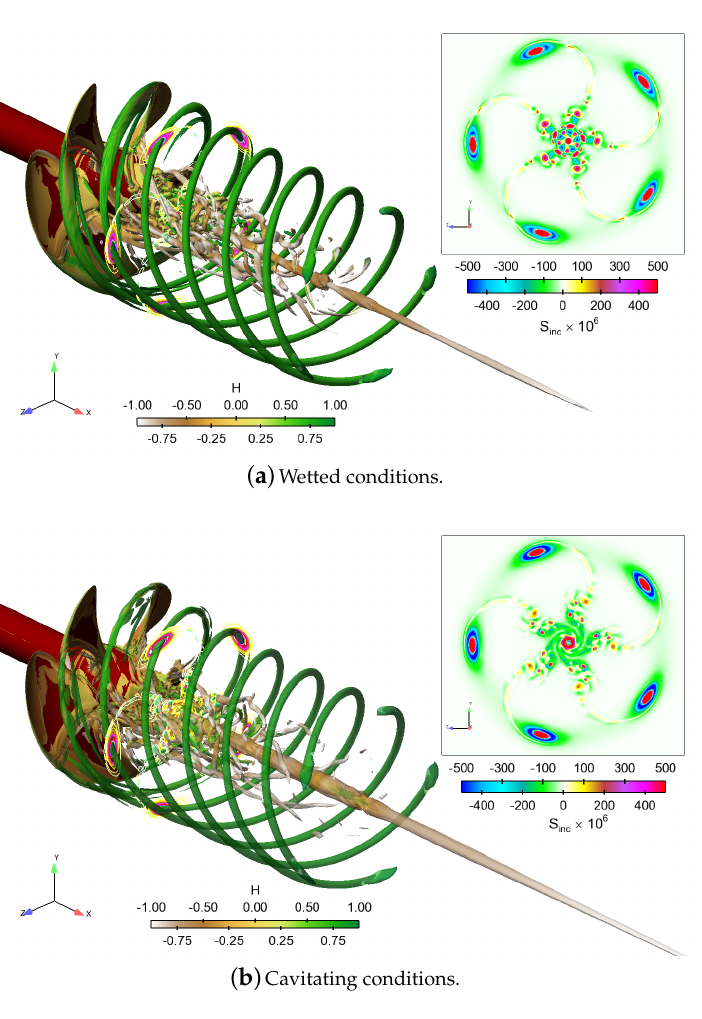
Figure 19. Vortical flow structures visualized with the Q criterion and acoustic source term distributions in the propeller wake. The Q criterion is coloured by helicity. The boxed figure in the upper right corner shows the acoustic source term distribution on the plane x / D = 0.5.